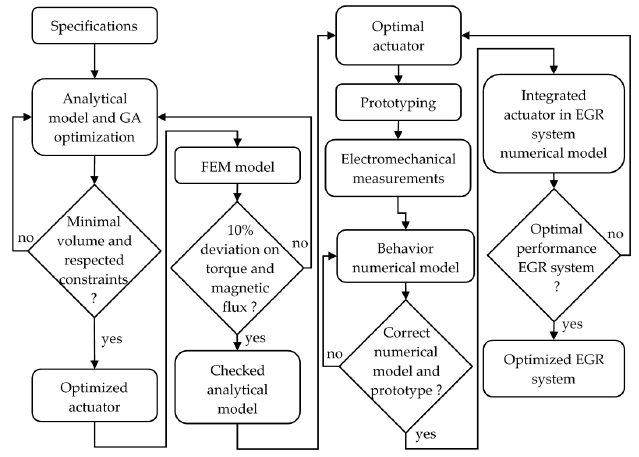
Figure 3. The flowchart procedure to design the prototype direct drive actuator.